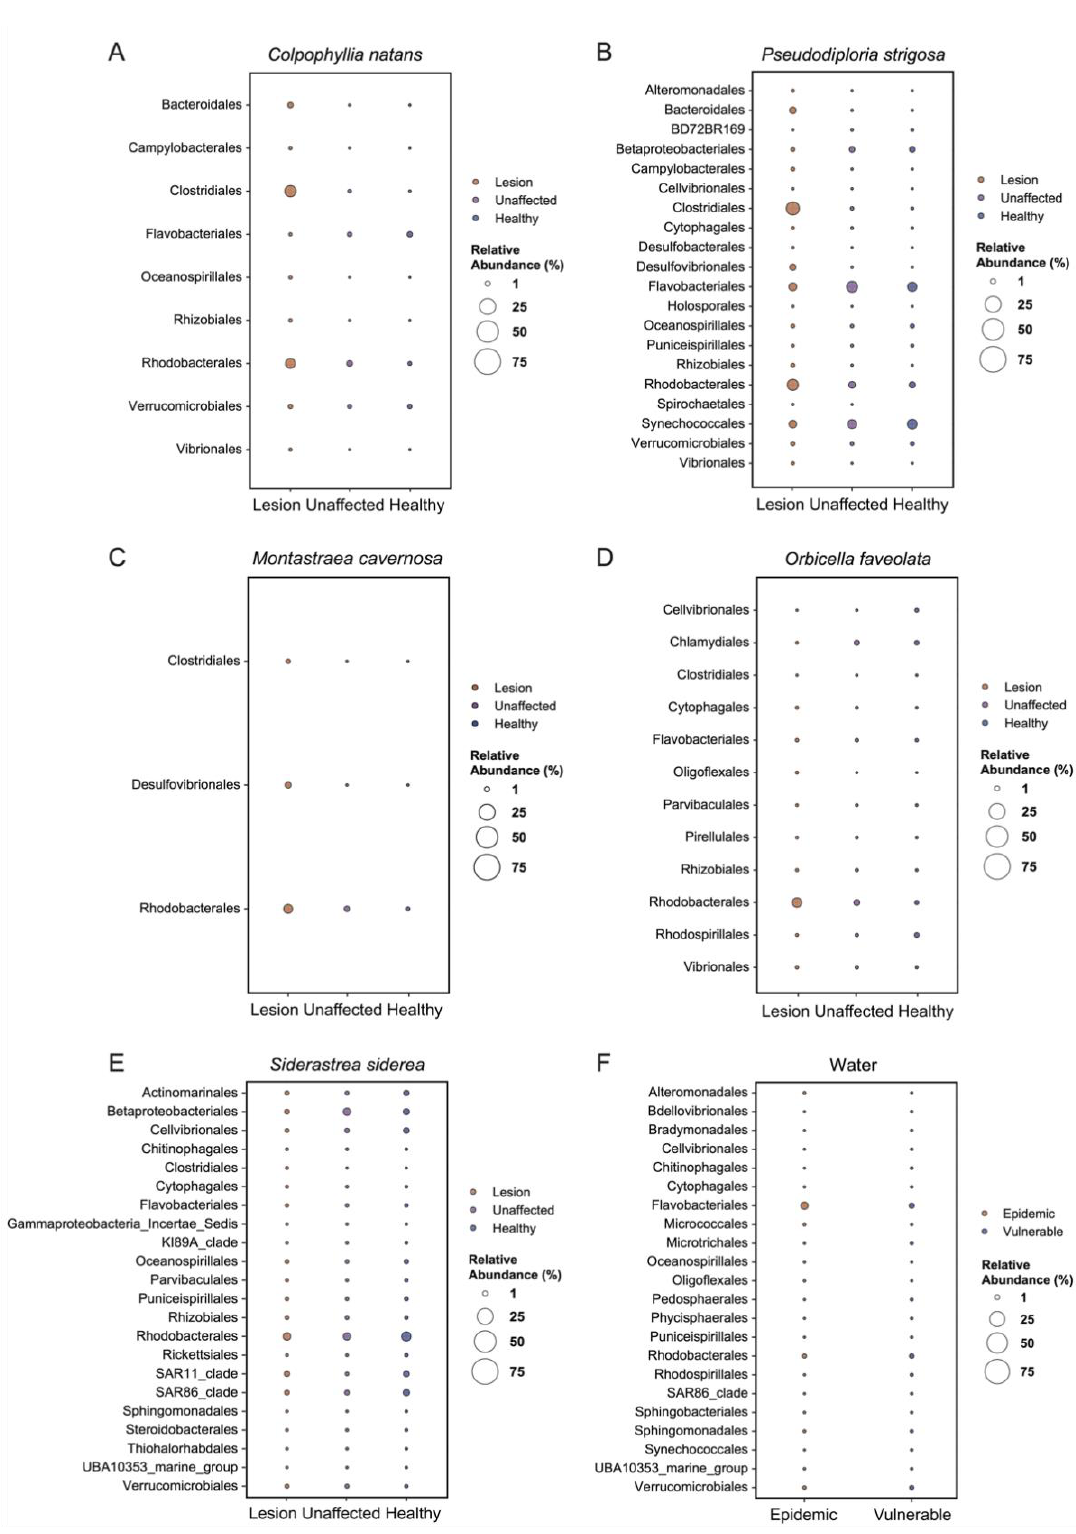
Figure 8. Relative abundances of significantly differentiated taxa (i.e., taxa with W-statistic values greater than a detection threshold of 0.7) in lesion and unaffected tissues from colonies with stony coral tissue loss disease, and tissue of apparently healthy colonies, collected from five coral species: ( A ) Colpophyllia natans , ( B ) Pseudodiploria strigosa , ( C ) Montastraea cavernosa , ( D ) Orbicella faveolata , and ( E ) Siderastrea siderea . Additionally, displayed is the relative abundance of significant taxa detected in ( F ) water samples collected at sites in the epidemic zone and at sites in the vulnerable zone. Taxa are grouped by order.